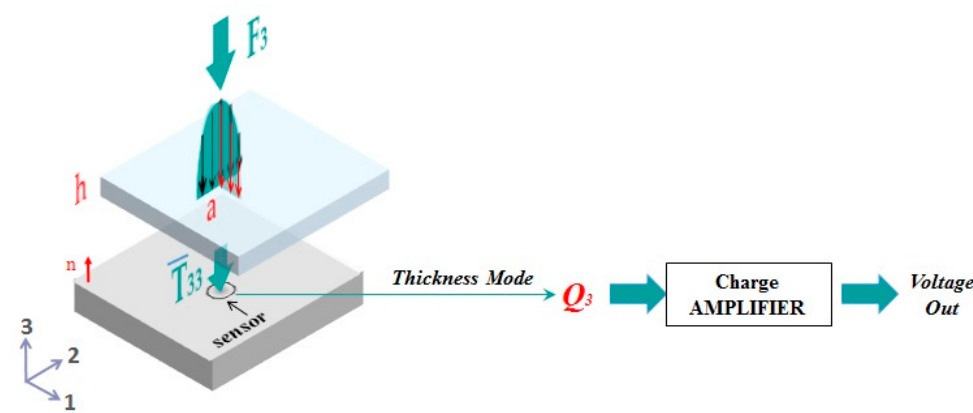
Figure 6. Sketch of the general working mechanism of the P(VDF-TrFE) sensor: The Hertzian input force (with contact radius a ) is transmitted to the sensor (with radius r T ) through the elastomer layer of thickness h . With the presupposition that the sensor works solely in compressive mode, it directly converts the received normal stress T 3 into electrical displacement D 3 , through a characterizing piezoelectric coefficient, namely the d 33 (1). A charge amplifier is used to convert the total sensor charge into voltage.